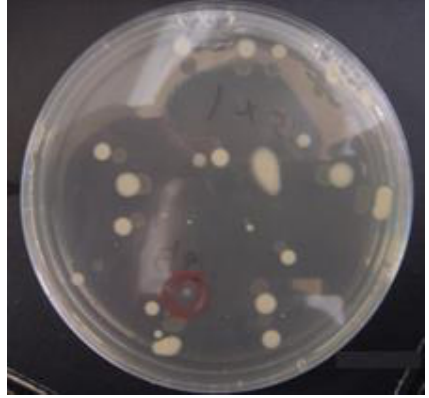
Figure 3. Staphylococcus sp . (No. P-100826-4-6 ) derived from Corallina officinalis L.